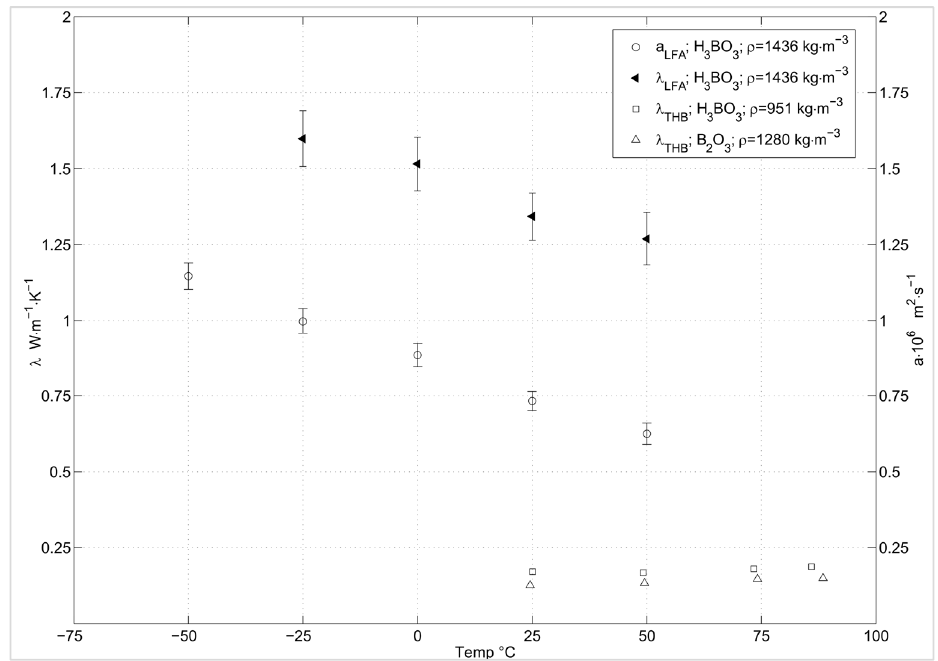
Figure 7. Thermal conductivity ( λ ) and thermal diffusivity (a × 10 6 ) for B 2 O 3 and H 3 BO 3 (pellet and powder) [30].